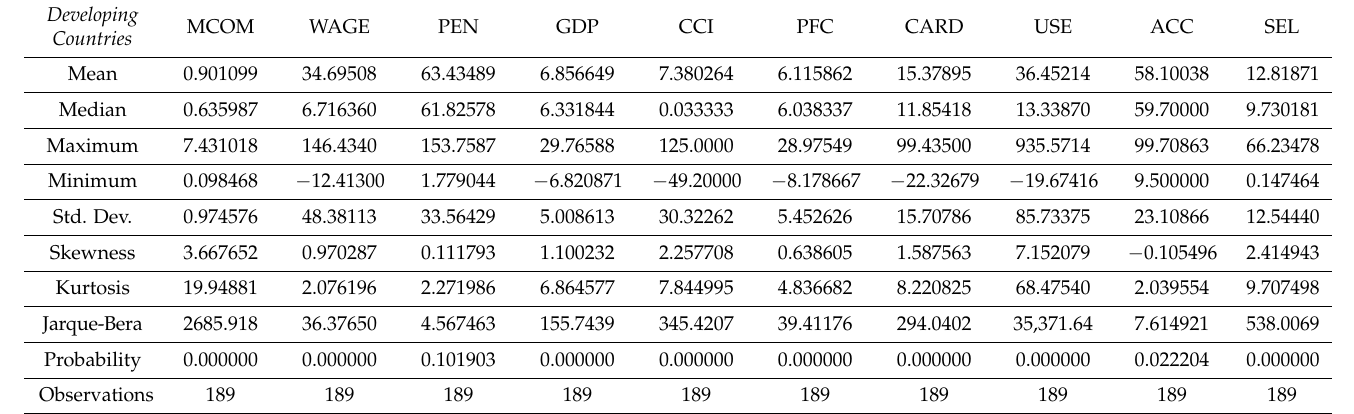
Table A2. Descriptive analyses of developing countries.